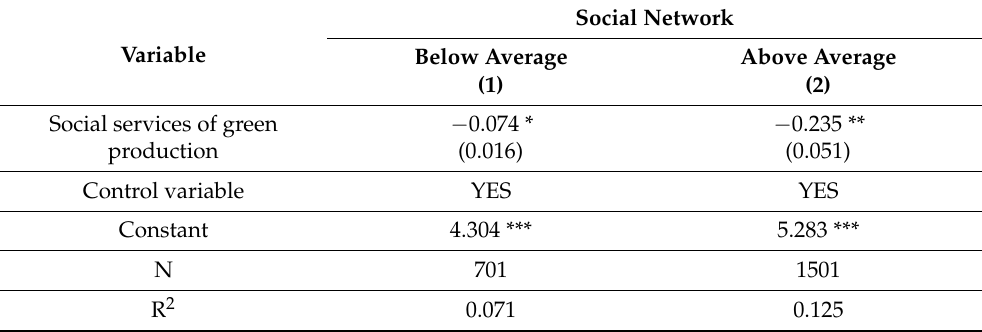
Table 5. Influence of socialized services of green production on farmers’ fertilizer use with different social network levels: extended analysis. Social Network Variable Below Average Above Average (1) (2) − 0.074 * − 0.235 ** Social services of green production (0.016) (0.051) Control variable YES YES Constant 4.304 *** 5.283 *** N 701 1501 R 2 0.071